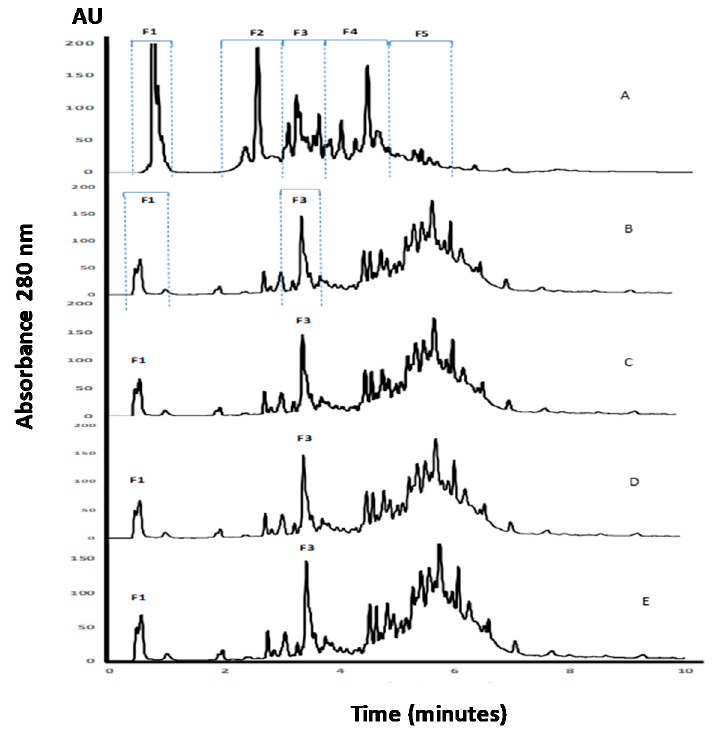
Figure 2. RP-UHPLC analysis of APC and its gastrointestinal hydrolysates. (A) APC, (B) gastric hydrolysate (pH 1.2), (C) gastric hydrolysate (pH 2.0), (D) gastric hydrolysate (pH 3.2), (E) gastrointestinal hydrolysate (pepsin pH 3.2 and pancreatin pH 7.0).